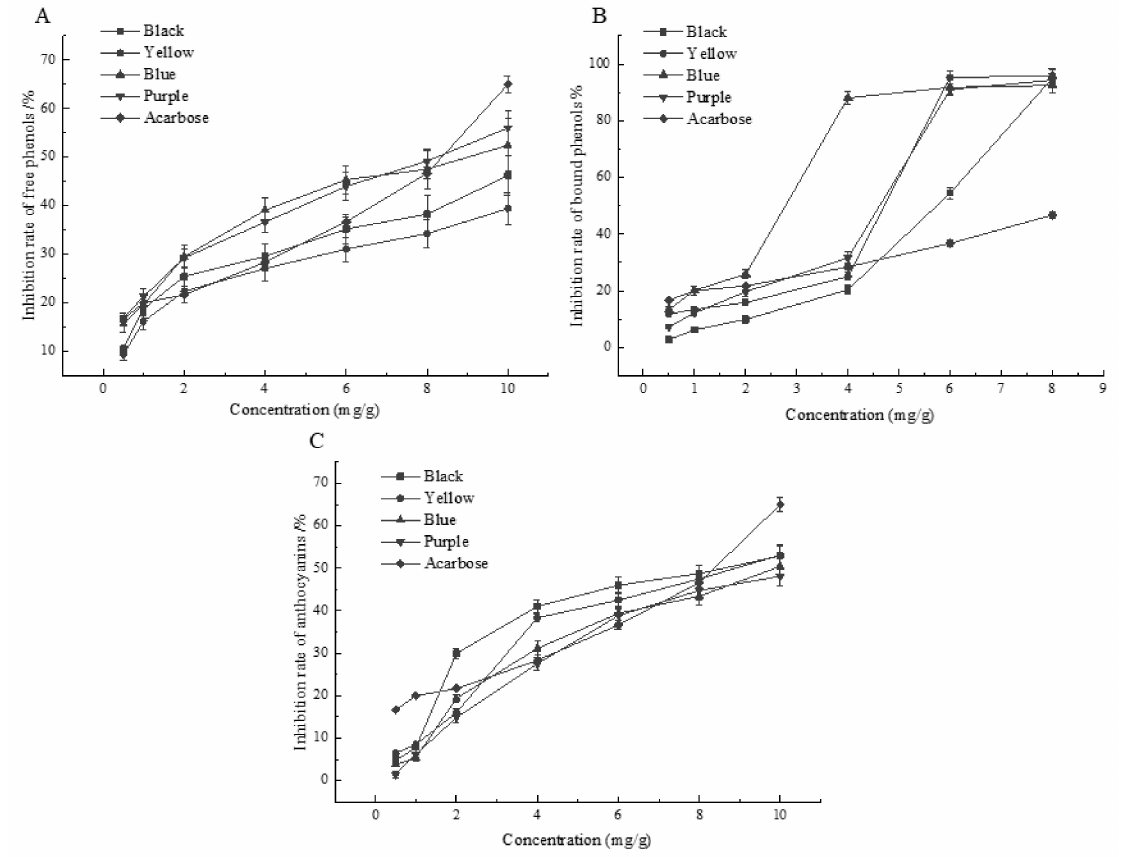
Figure 6. Inhibition of α -glucosidase activity in vitro by phenolic fractions of barley of different colors. ( A ) Inhibition rate of free phenolic compounds; ( B ) inhibition rate of bound phenolic compounds; ( C ) inhibition rate of